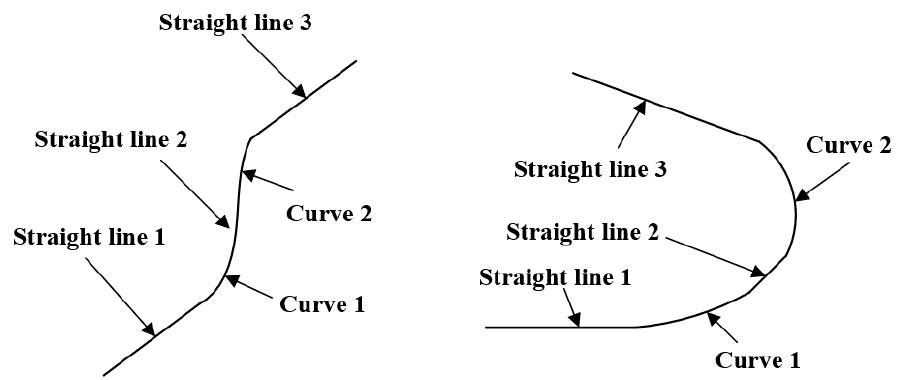
Figure 7. S-shaped curve line and C-shaped curve line.